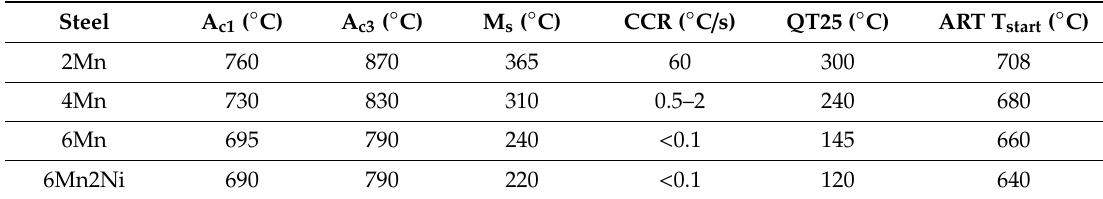
Table 2. Experimental phase transformation temperatures, critical cooling rate (CCR) to avoid di ff usion-based phase transformations, quenching temperature where 0.25 austenite exists (QT25), and temperature for the start of austenite reverse transformation (ART T start ) in the studied steels considering an austenization temperature of A c3 + 50 ◦